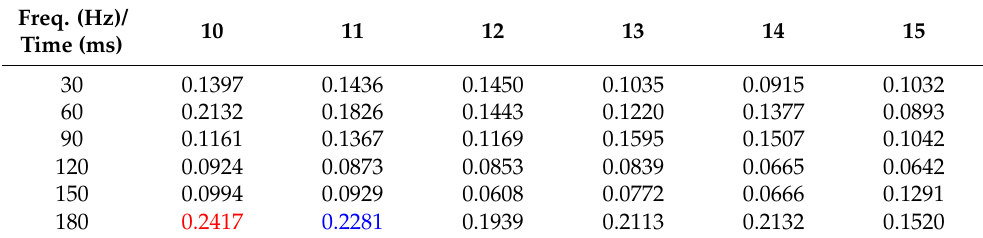
Table 8. The data of HS2 of class I, main frequency band 10–15 Hz, sampling time interval 30 ms. The maximum and second-highest energy ratios are highlighted in red and blue, respectively.